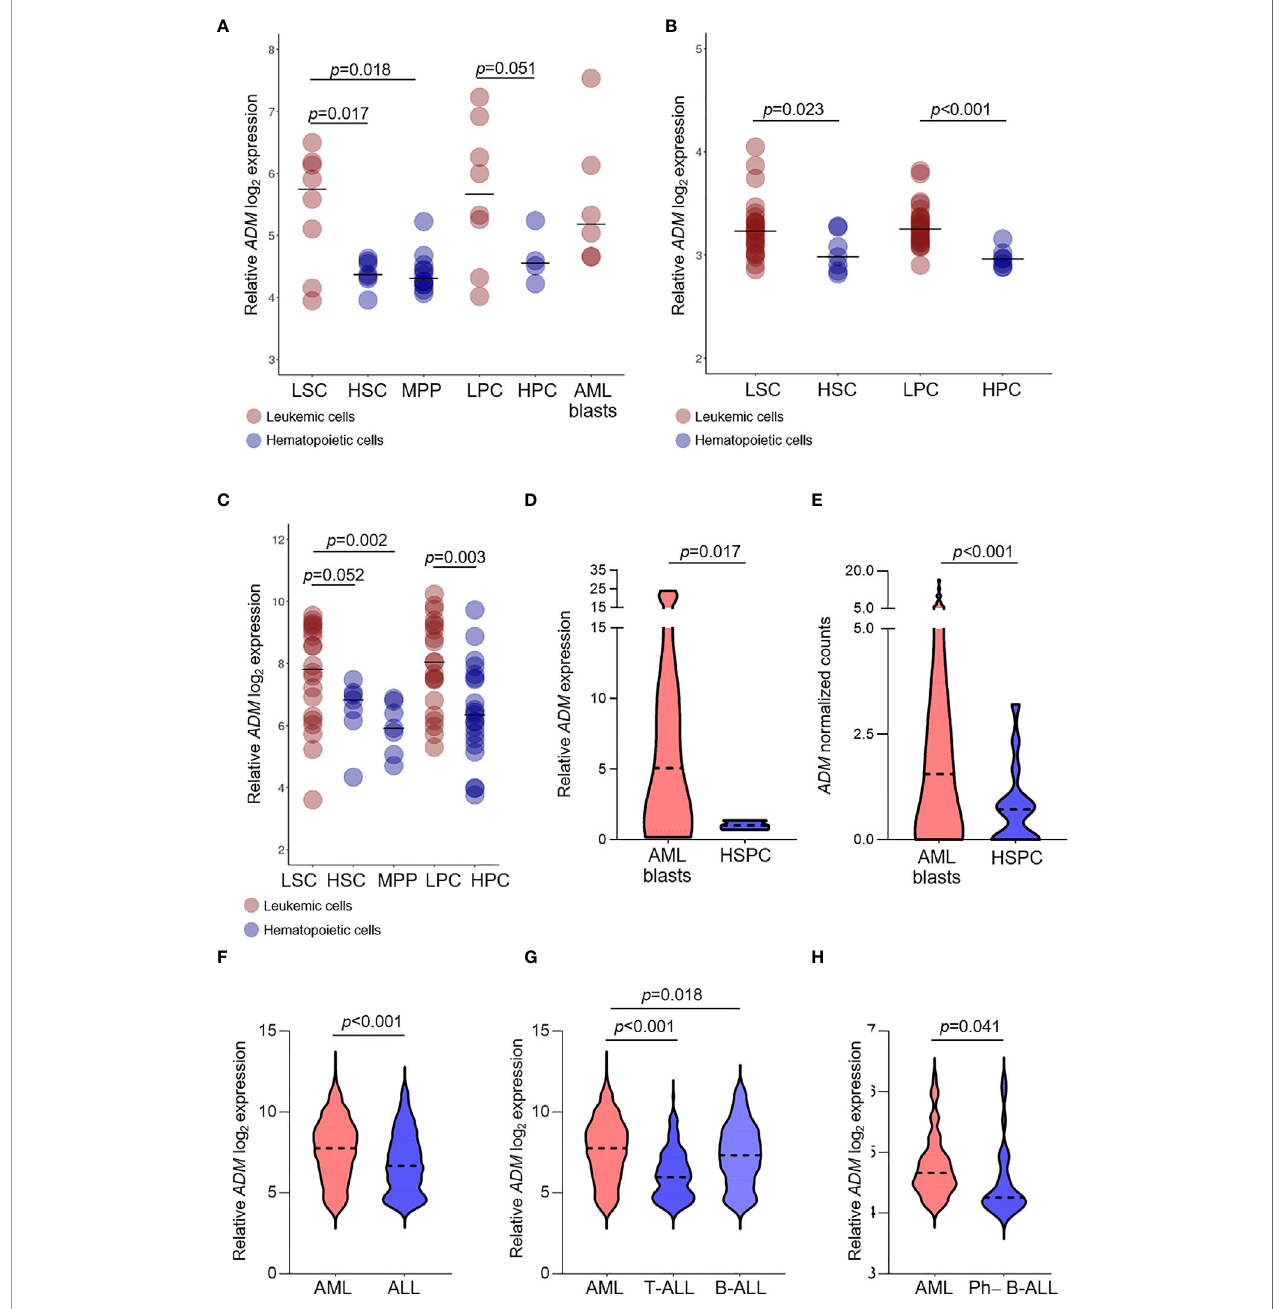
FIGURE 2 | ADM expression is elevated in leukemic compared with hematopoietic stem and progenitor cells and in AML compared with ALL. (A – C) Comparison of ADM levels between leukemic cells subpopulations and normal stem and progenitor cells in the GSE24006 (A) , the GSE117090 (B) and the GSE63270 (C) datasets. Subpopulations according to their surface phenotype: leukemia stem cells (LSC): (Lin − )CD34 + CD38 − (CD90 − ), hematopoietic stem cells (HSC): Lin − CD34 + CD38 − CD90 + (CD45RA +/ − ), hematopoietic multipotent progenitor cells (MPP): Lin − CD34 + CD38 − CD90 − CD45RA − , leukemia progenitor cells (LPC): (Lin − ) CD34 + CD38 + (CD90 − ), hematopoietic progenitor cells (HPC): Lin − CD34 + CD38 + (CD90 + ), AML blasts: Lin − CD34 − . Scatter plots were generated with the R package ggplot2 (48) (version 3.3.1). Each dot indicates one sample and the bar represents the median value. (D) Comparison of ADM levels between AML blasts (n = 12) and healthy CD34 + bone marrow cells (n = 3, hematopoietic stem-progenitor cells, HSPC, qRT-PCR) and (E) between AML blasts (n = 60) and healthy G-CSF mobilized HSPC (n = 16) from the GSE158596 dataset. (F) ADM transcript levels in AML (n = 505) and ALL (n = 784, GSE13159), (G) separated in T-ALL (n = 173) and B-ALL (n = 441) and (H) in AML (n = 61) versus Ph − B-ALL (n = 29, NGS-PTL). Violin plots were generated with GraphPad Prims (version 8.4.3). The plots represent the frequency distribution of ADM levels (from minimum to maximum) and the dotted line indicates the median